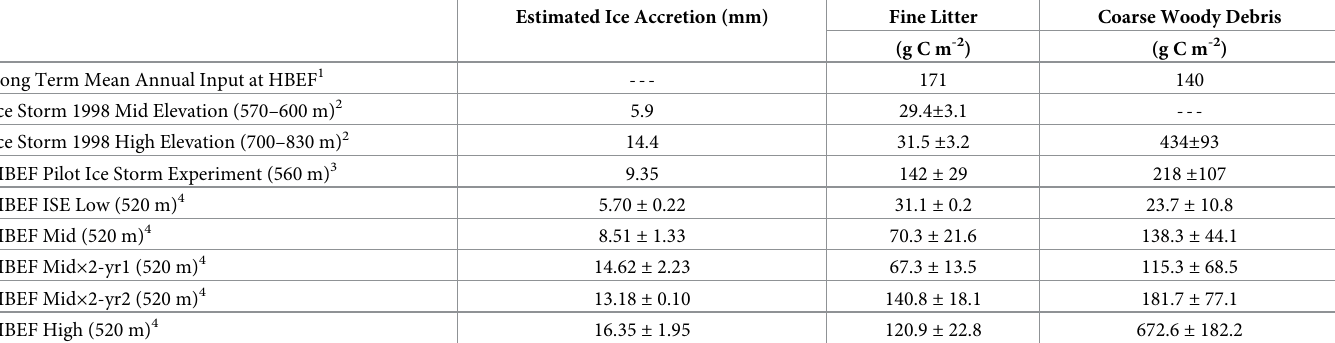
Table 7. Comparison of estimated ice accretion, fine litter-C, and coarse woody debris-C for the Hubbard Brook Experimental Forest (HBEF) long term mean annual input, ice storm of 1998, HBEF 2012 pilot ice storm experiment, and current ice storm